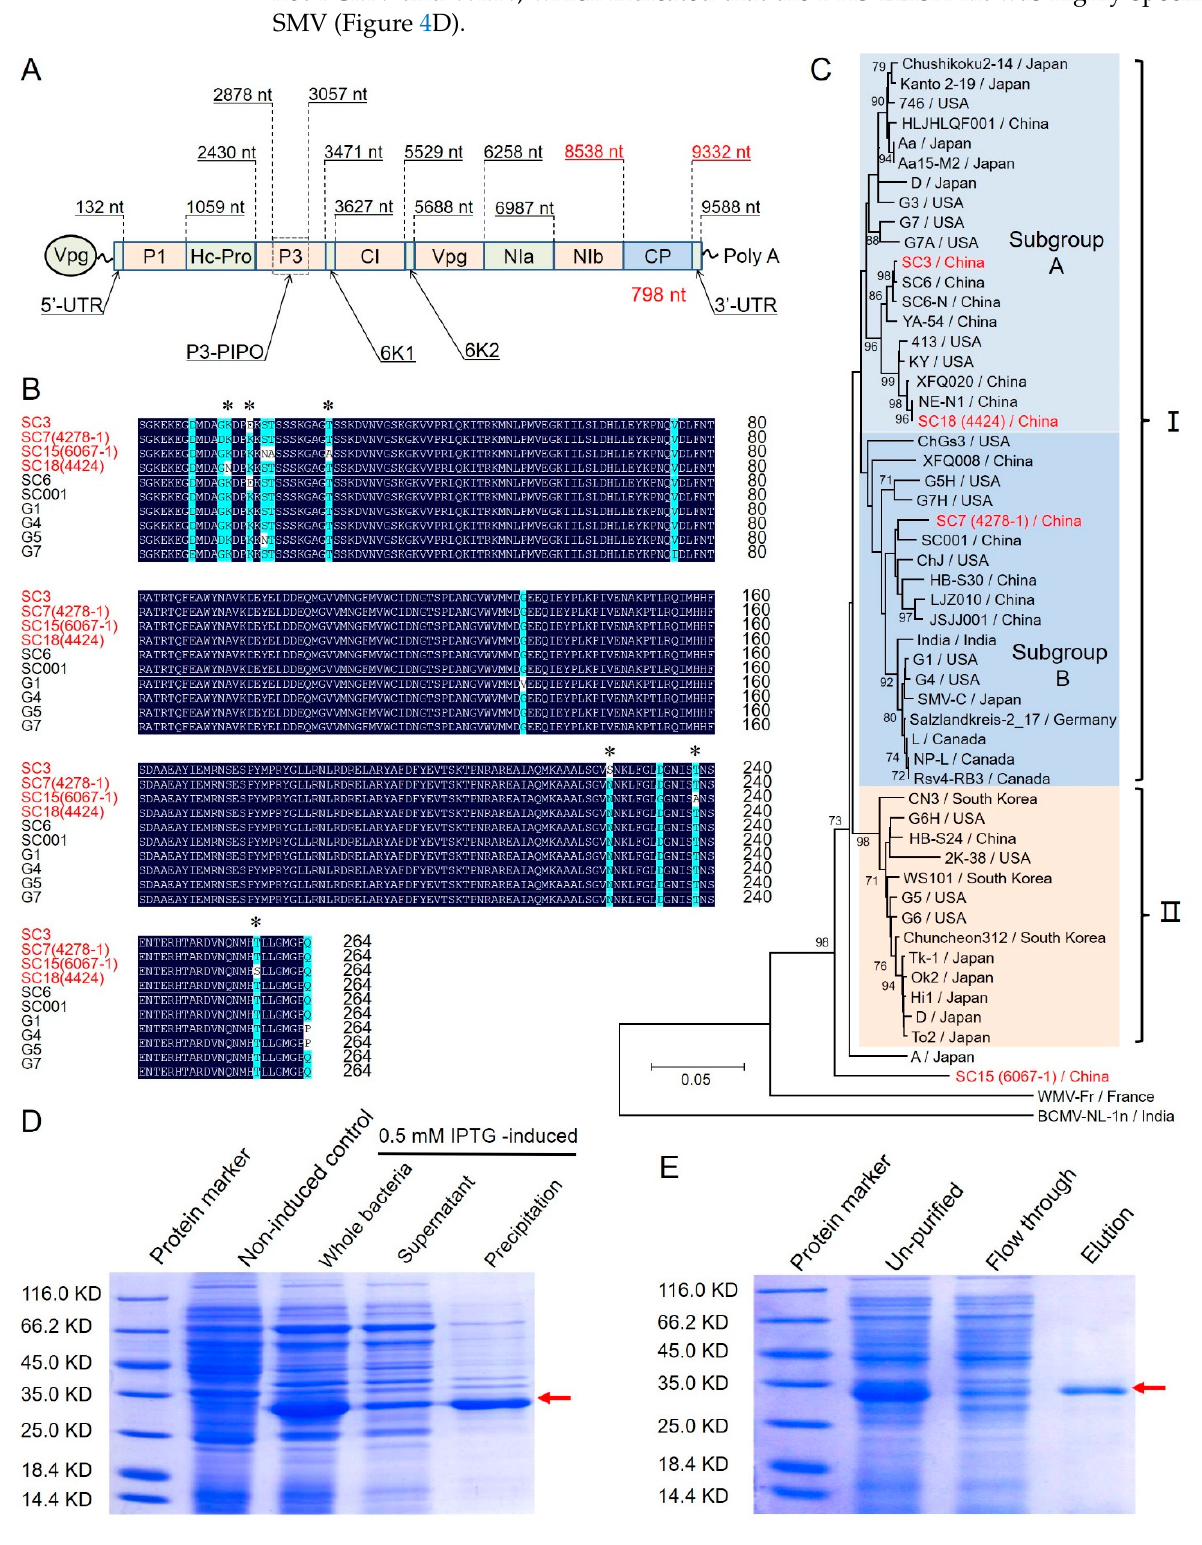
Figure 3. Cloning, sequence analysis and prokaryotic expression of the SMV-cp gene. ( A ) The genome organization of SMV; ( B ) sequence alignment of the SMV-cp genes of SC3, SC7, SC15 and SC18 with other prevalent SMV strains in China (SC6 and SC001) and America (G1, G4, G5 and G7); ( C ) the phylogenetic tree of SMV isolates structured based on deduced SMV-CP amino acid se- quences. The phylogenetic tree was constructed using the neighbor-joining method with the 1000 bootstrap values indicated; ( D ) the expression of SMV-CP was determined via sodium dodecyl sul- fate–polyacrylamide gel (SDS-PAGE) analysis; ( E ) the purification of SMV-CP was also determined via SDS-PAGE. * indicates polymorphic site in amino acid sequences of SC3, SC7, SC15 and SC18 in